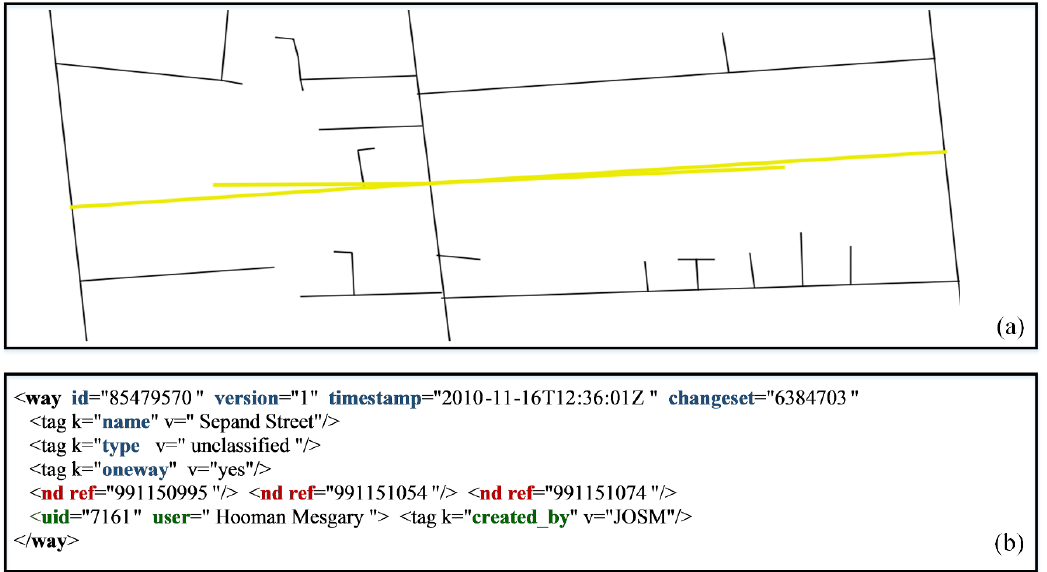
Figure 3. ( a ) A part of the street network from OSM of Tehran; ( b ) a sample of the OSM history file for Sepand Street (yellow line) in version 1.